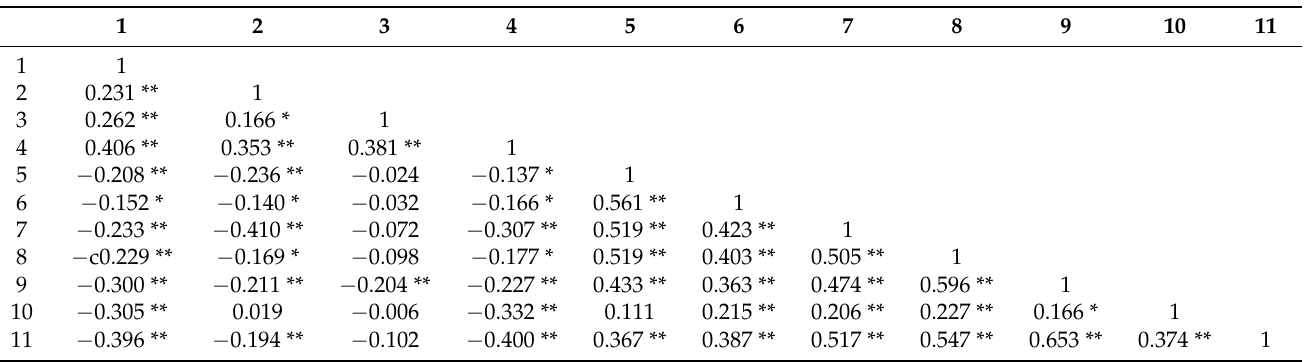
Table 3. Analysis of correlation between